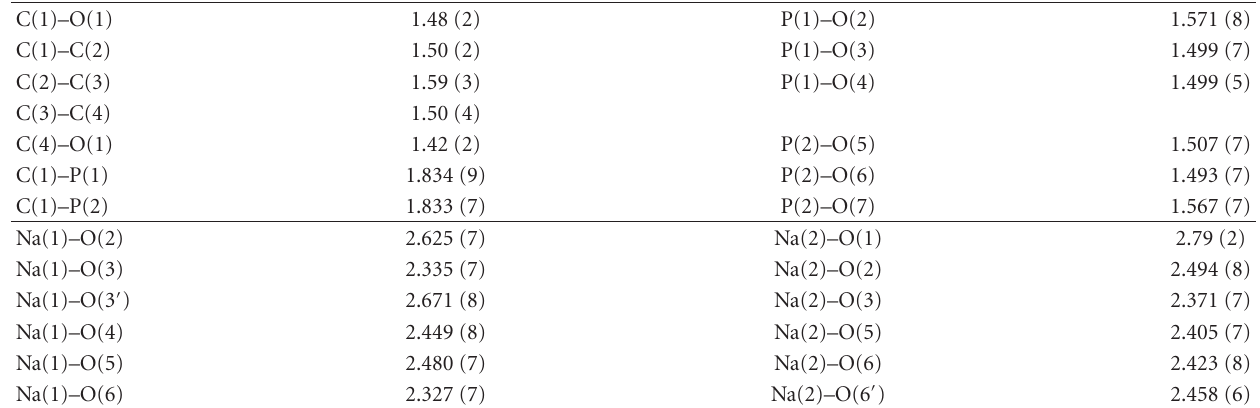
Table 2: Selected bond lengths (˚A) for Na 2 H 2 L.